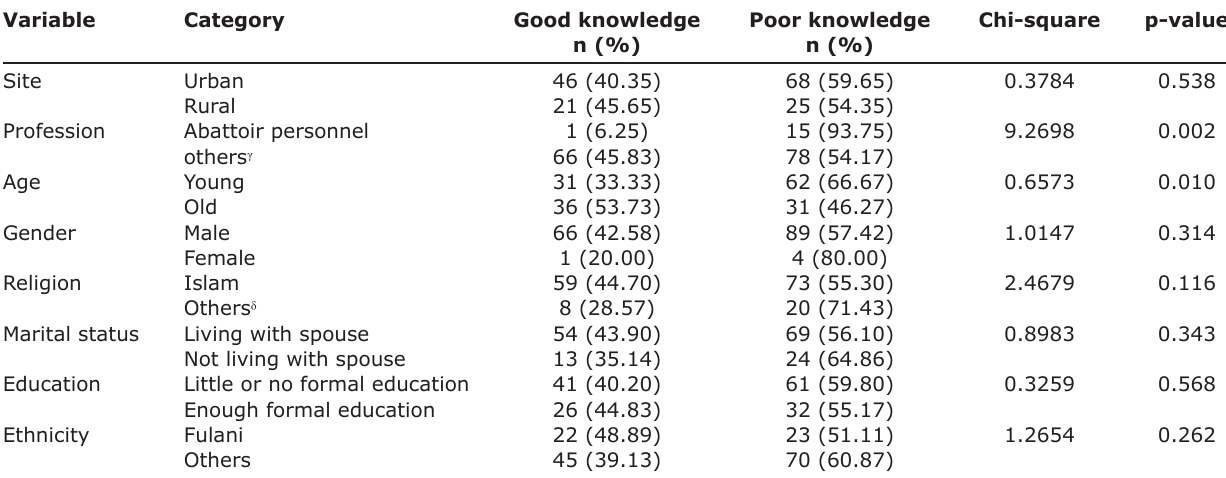
Table-2: Factors influencing levels of knowledge about brucellosis amongst high-risk persons in Lafia Nasarawa State, Nigeria (n=160). Variable